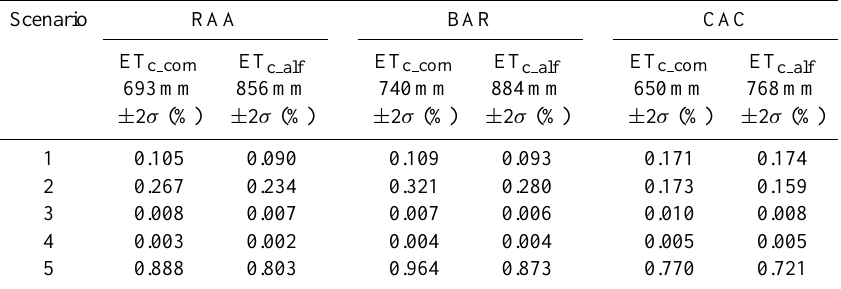
Table 5. Values of average annual ET c corn and ET c alf (mm) during the period 2004–2011 with their associated error value ( ± 2 σ ) according to different scenarios (Table 3). Irrigation districts of Riegos del Alto Arag´on (RAA, Gra˜n´en weather station), Canal de Bardenas (BAR,